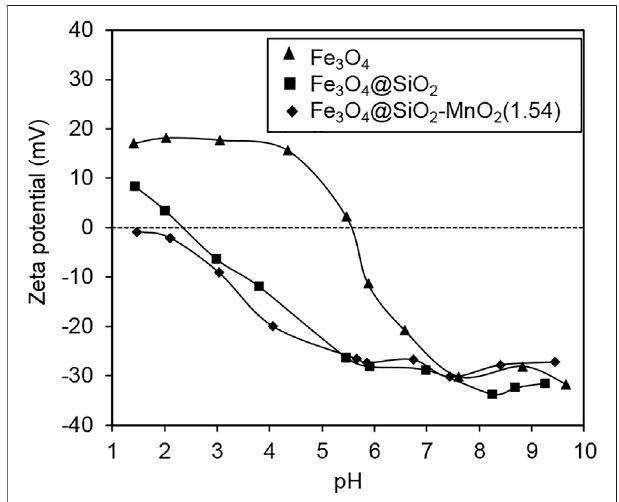
FIGURE 4 | Surface zeta potentials of the samples as a function of pH.